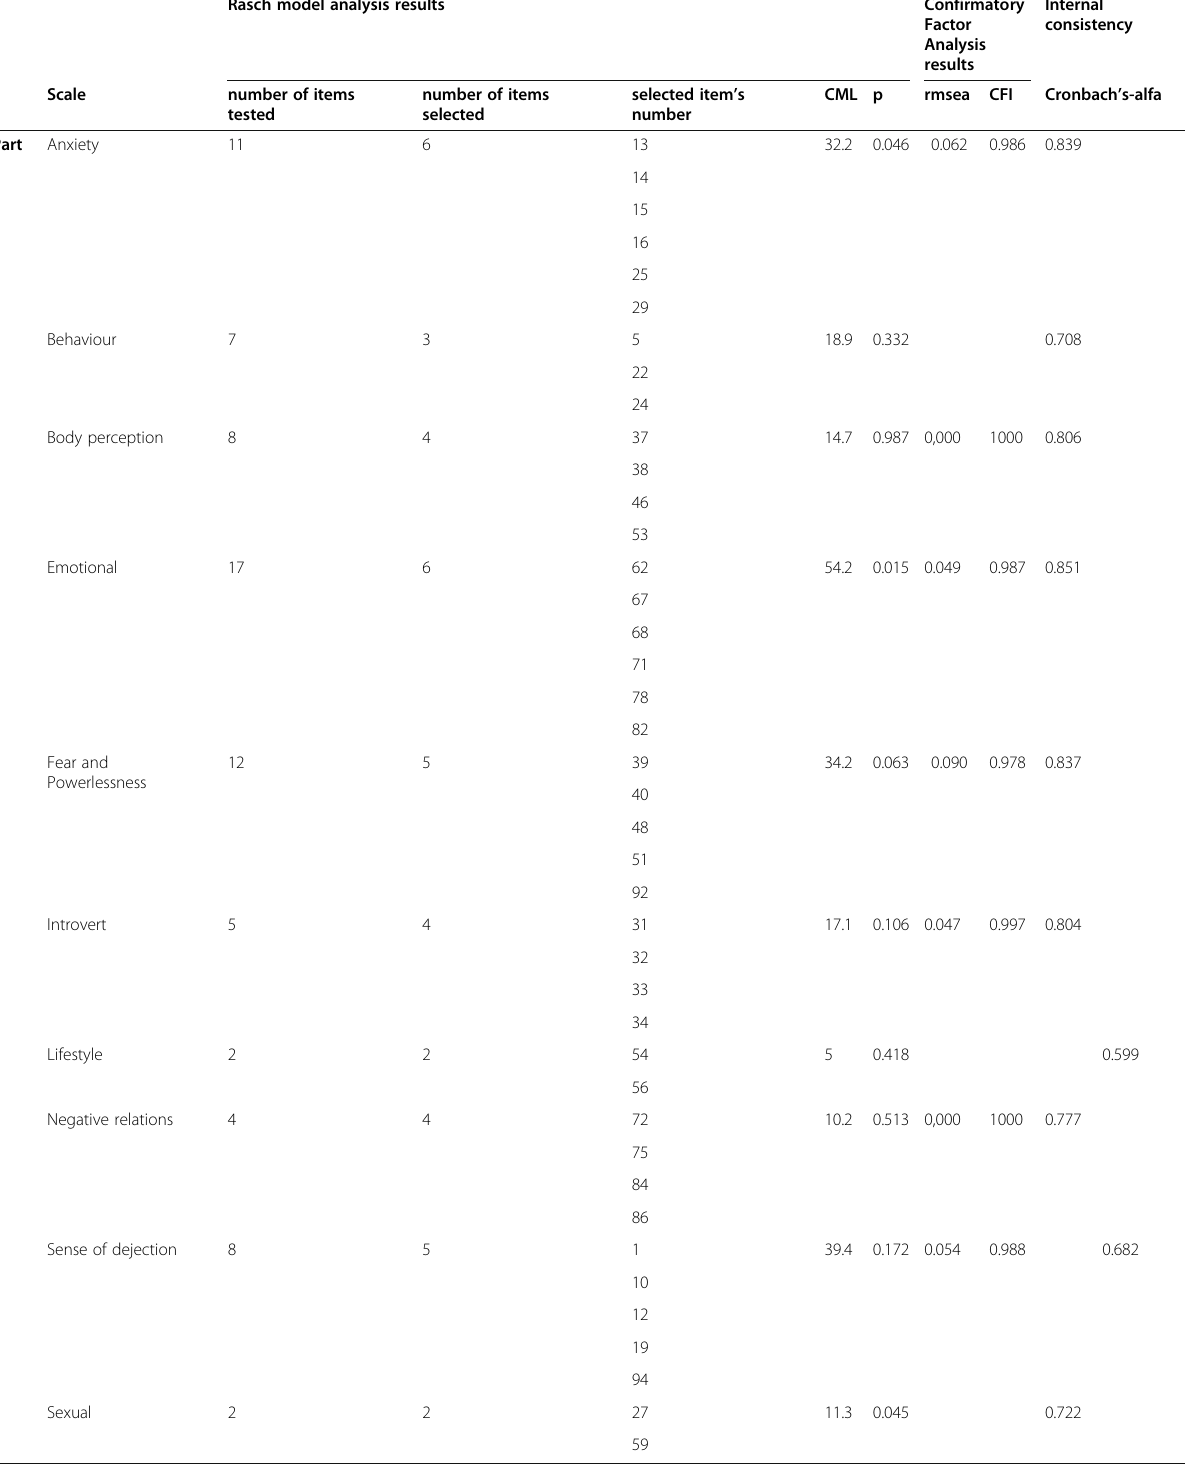
Table 4 Selected items: part